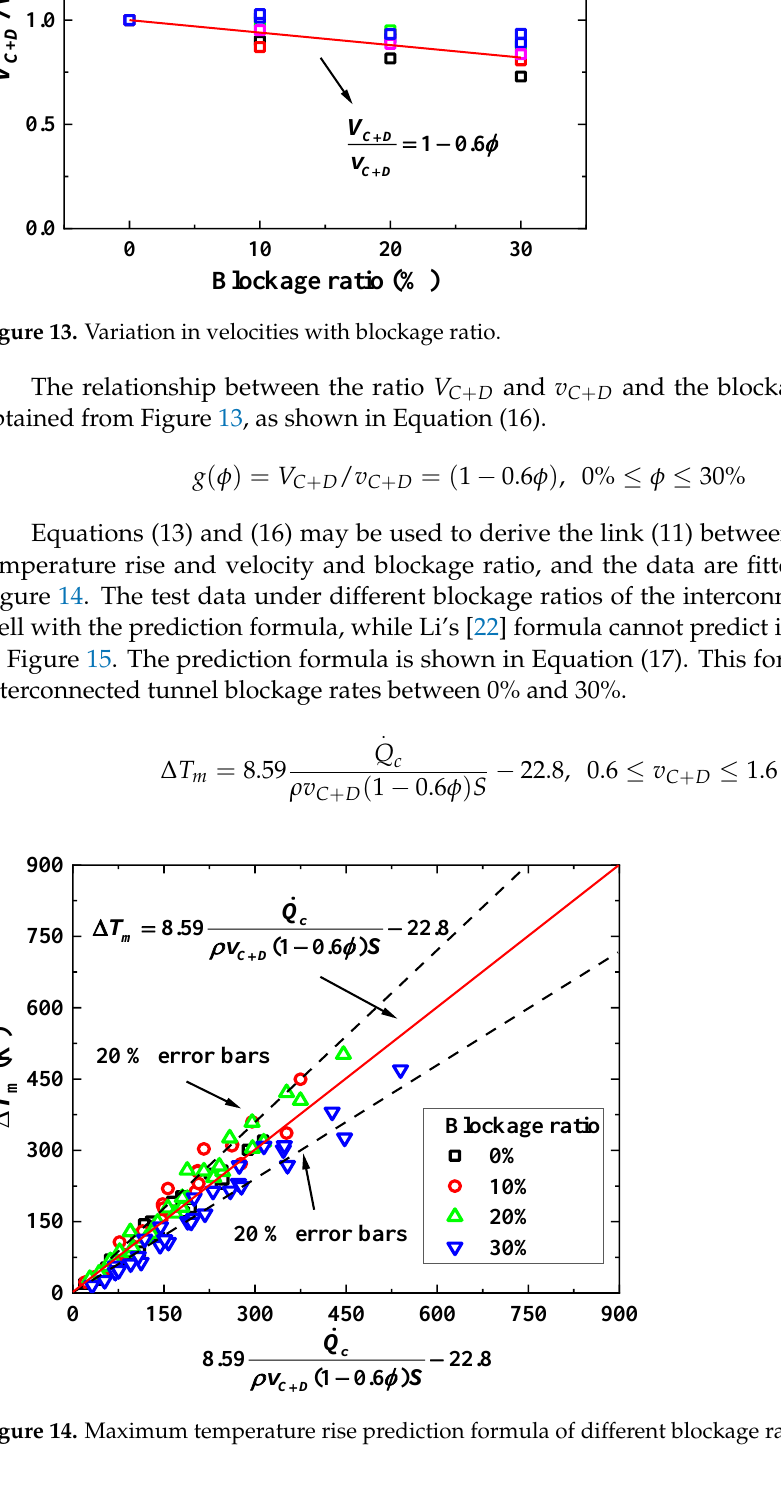
Figure 14. Maximum temperature rise prediction formula of different blockage ratios.